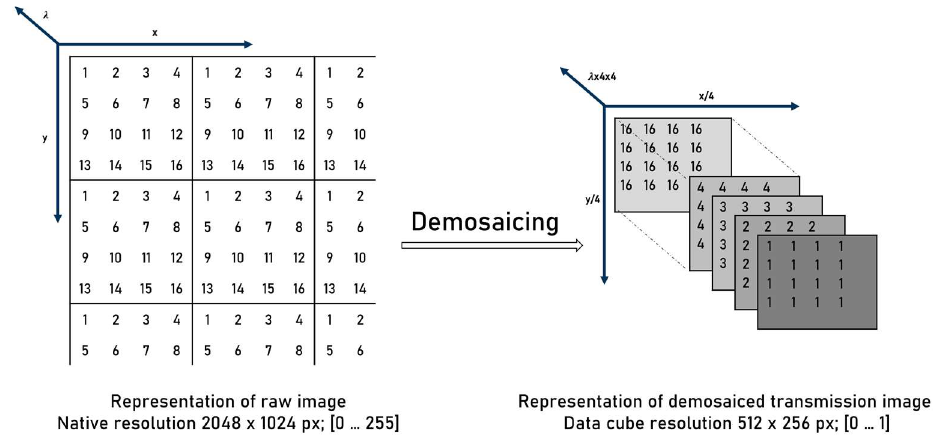
Figure 3. Resolution and value range of snapshot-mosaic camera images.